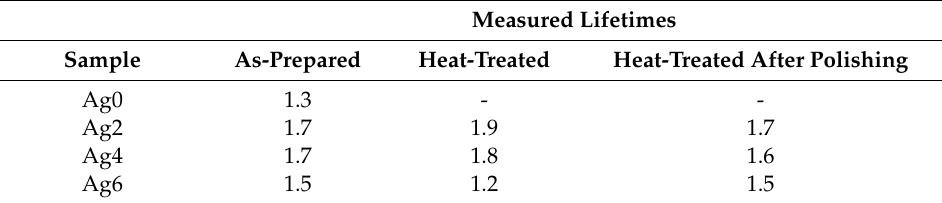
Table 5. Er 3+ :I 13/2 measured lifetime (τ m ) values of the investigated glasses (±0.1 ms).